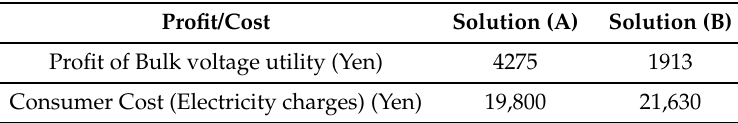
Table 1. Profit vs. cost representation of two Pareto